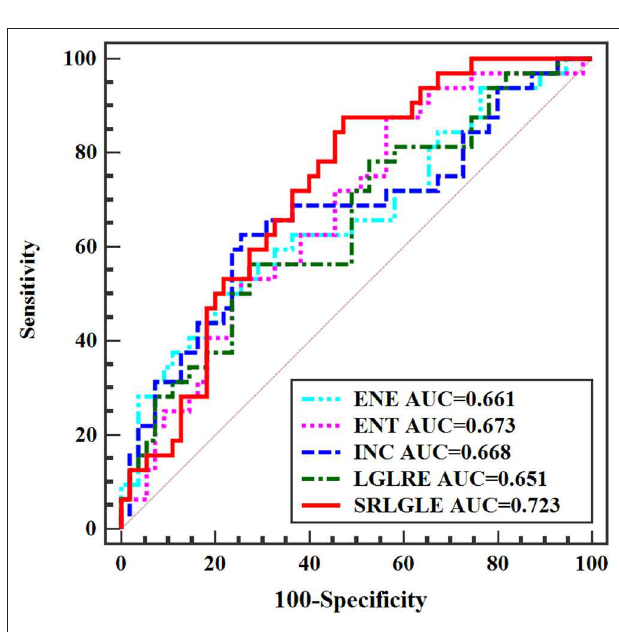
FIGURE 3 | ROC curves of statistically significant texture features extracted from sagittal fat-suppression T2WI for predicting N stage.